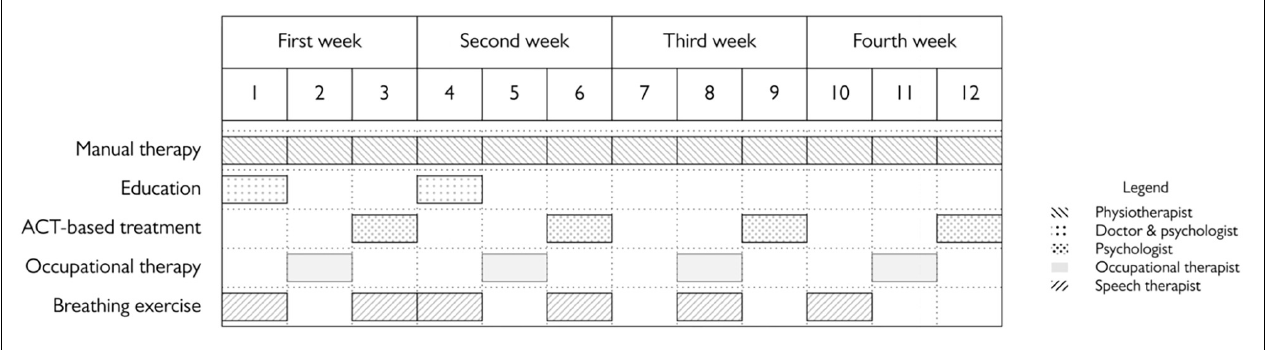
FIGURE 1 | Components of the interdisciplinary